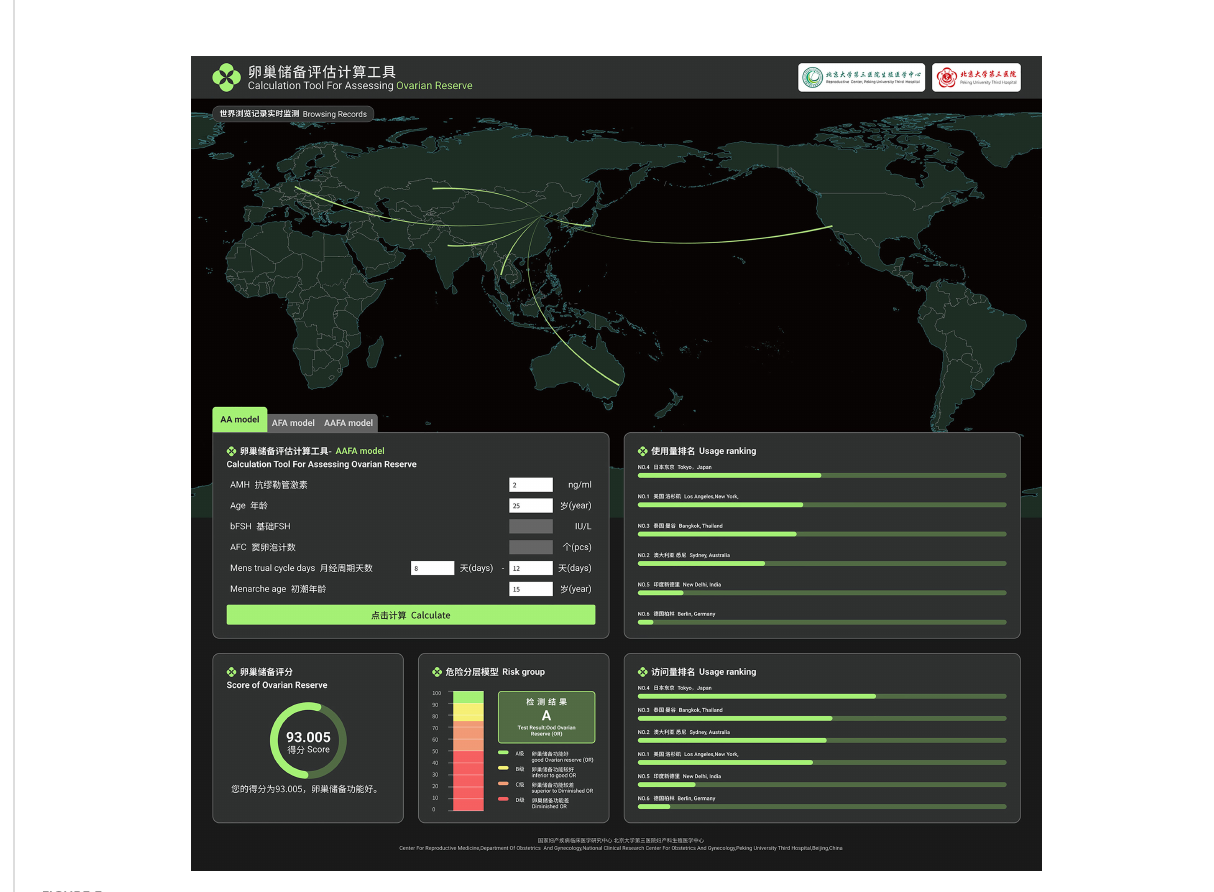
FIGURE 3 The website-based ovarian reserve assessment tool according to the AA model, improved AAFA model and improved AFA